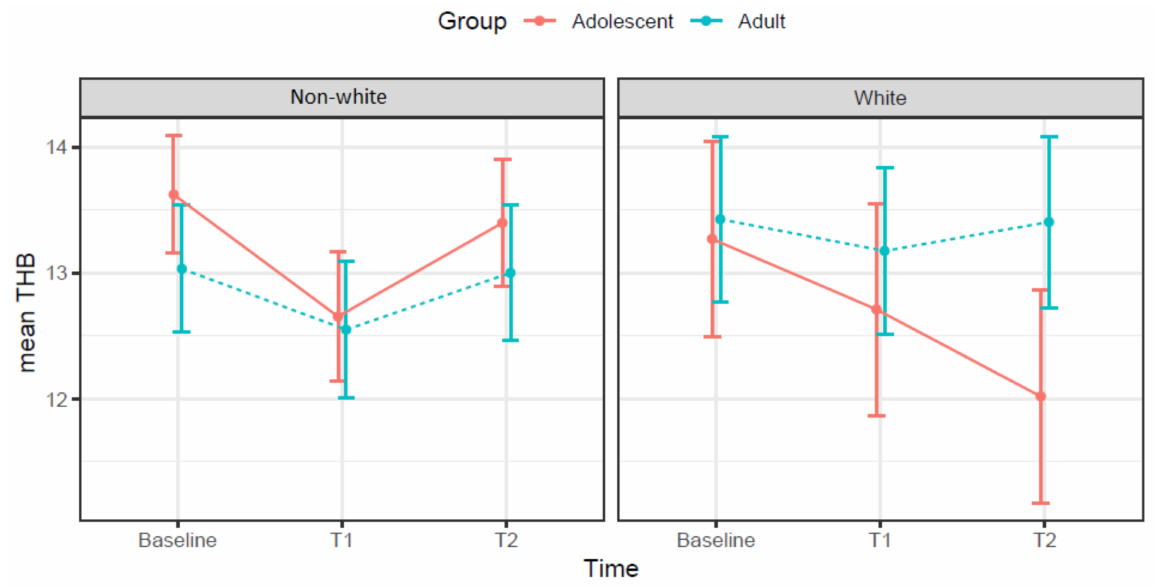
Figure 3. THB variation from the first 16 weeks of pregnancy (baseline) to the third trimester (T1) and the 4 to 6 weeks postpartum (T2) for white and non-white adolescents and adults. Trairi Region, Rio Grande do Norte, Brazil, 2017–2019.